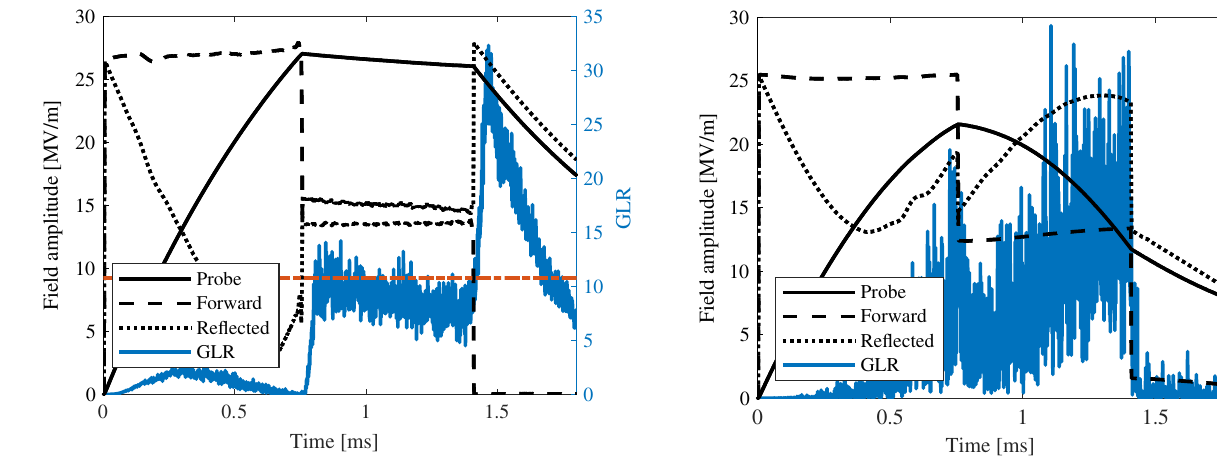
FIG. 16. All signals for changed detuning, seven pulses after the one shown in Fig.